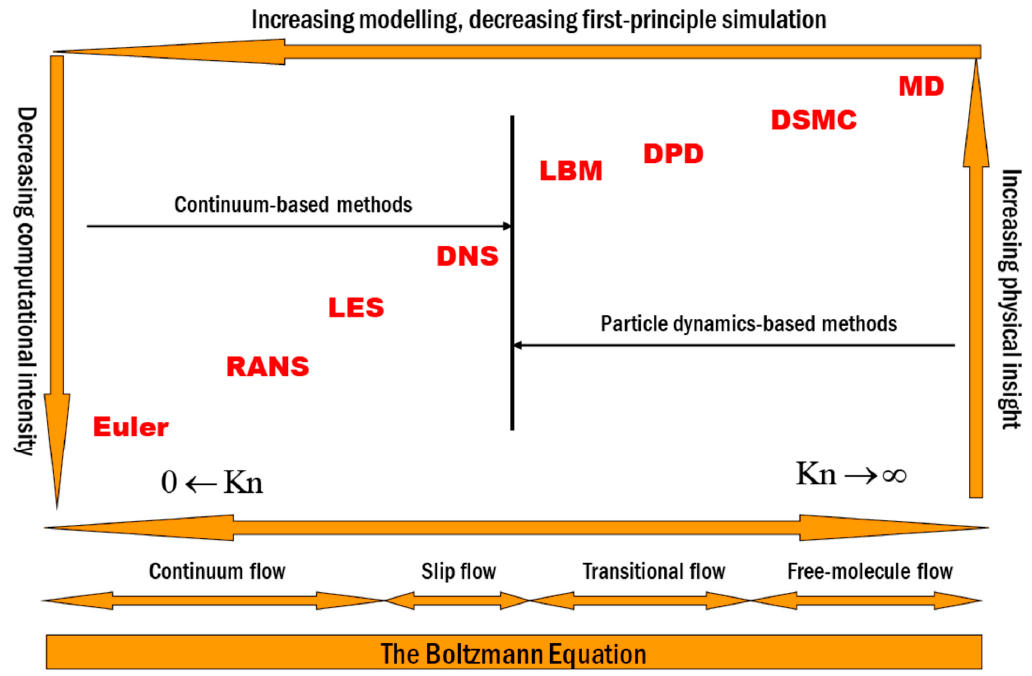
Figure 6. Various numerical models for simulation of appropriate particle problems based on the application problem dimensions. Adapted from [59].